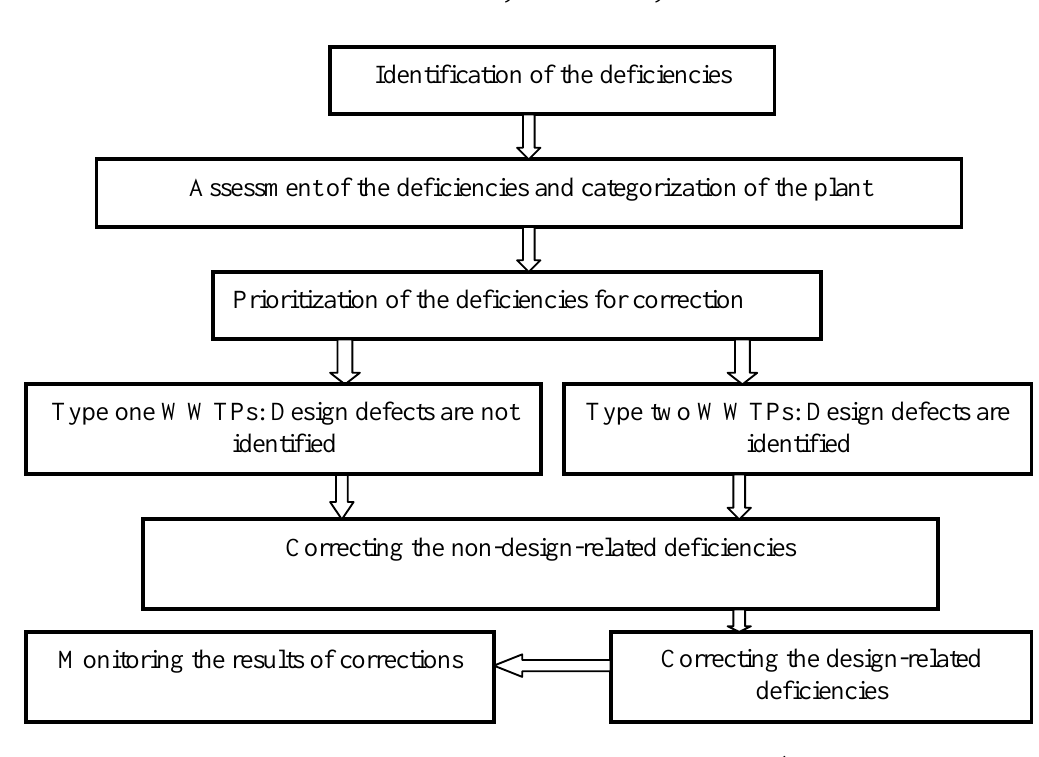
Fig. 8. Logical model for identifying and correcting the deficiencies at WWTPs (in part adapted from Diagger and Buttz, 1998).